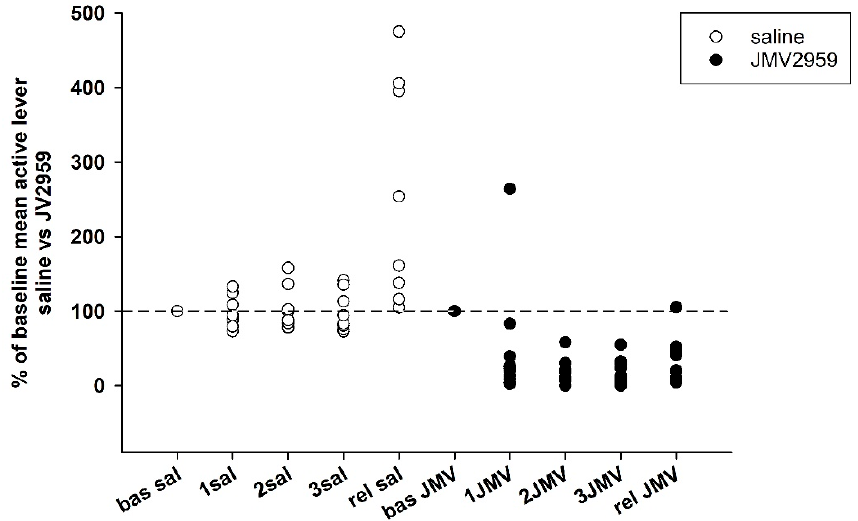
Figure 5. JMV2959 and saline effects on active lever-pressing during methamphetamine IVSA in single rats in percentage of baseline mean (mean of last three baselines before pretreatment). JMV2959 3 mg/kg and saline were administered i.p. 20 min before the session. The effects are illustrated as follows: saline (open circle), JMV2959 (filled circle). The dotted line shows the baseline mean level (100%; “bas”). During the relapse-like behavior testing session (“rel”), the rats were not connected to the infusion pump.